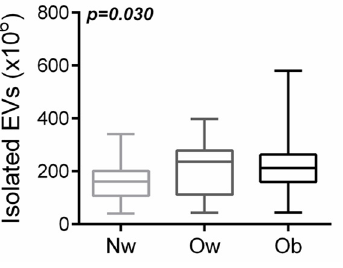
Figure 1. Quantification of circulating EVs by FACS analysis in participants with normal weight (Nw), overweight (Ow) and obesity (Ob).